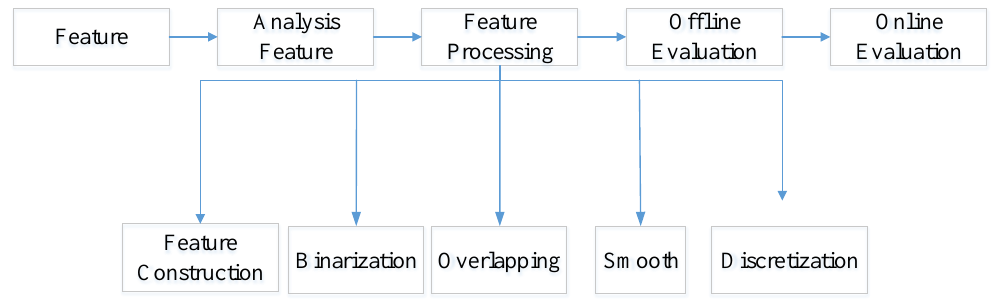
Figure 2. Diagram of the machine olfactory system.